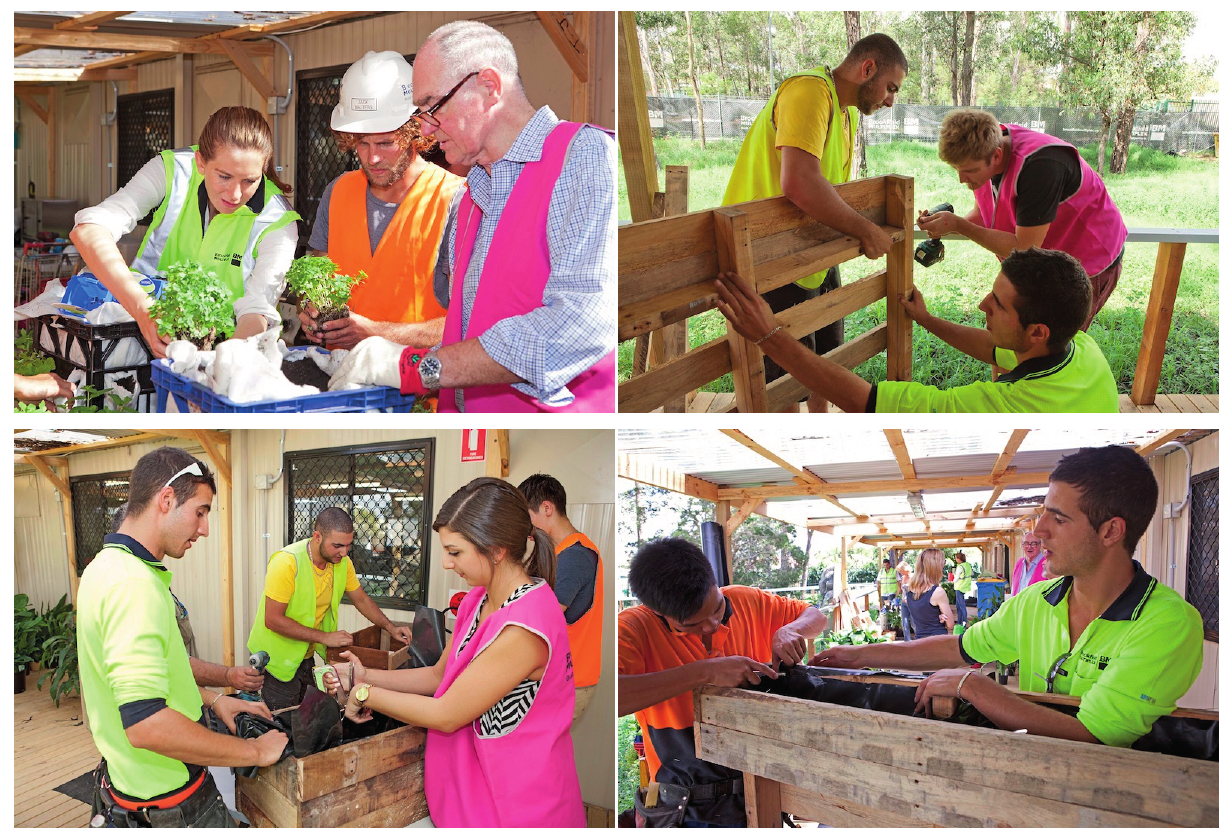
Figure 5. Collage of team building unfolding during working